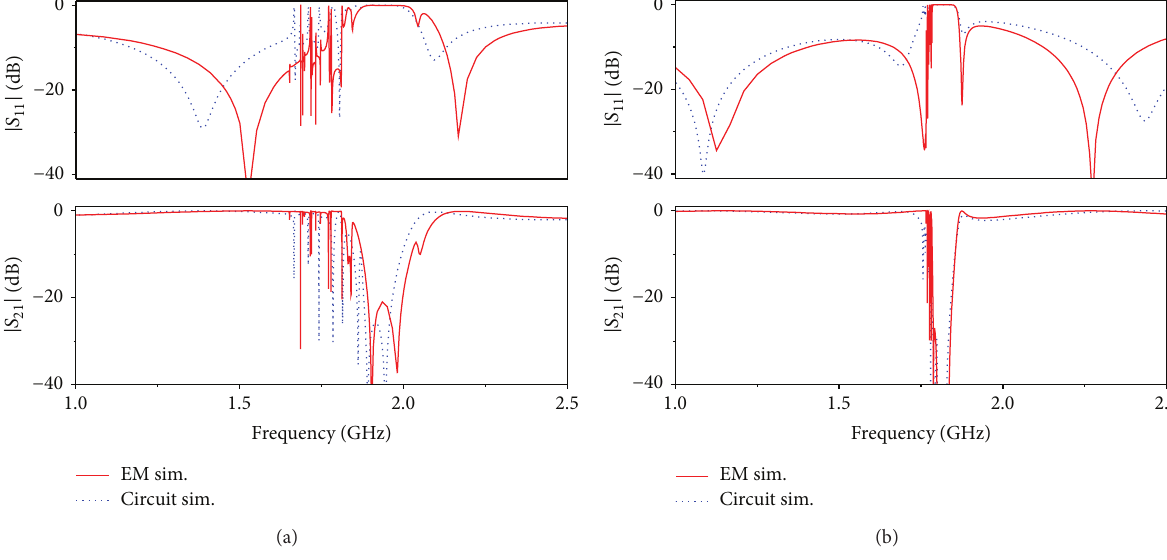
Figure 8: Lossless electromagnetic and circuit simulations of the transmission and reflection coefficients (magnitude) for nine cascaded cells of the structure in Figure 4 for (a) 𝑙 = 3 mm and (b) 𝑙 = 4.8 mm (the interresonator separation has been increased from 0.2 mm to 2mm). The circuit parameters are those indicated in the caption of Figure 5, with the exception of 𝑀 𝑅 = 0.22 nH in (b). Furthermore, in (b), a CPW section of 1.8 mm length has been cascaded between the port R1 and the port L1 of the contiguous cell in the circuit model. From [34], reprinted with